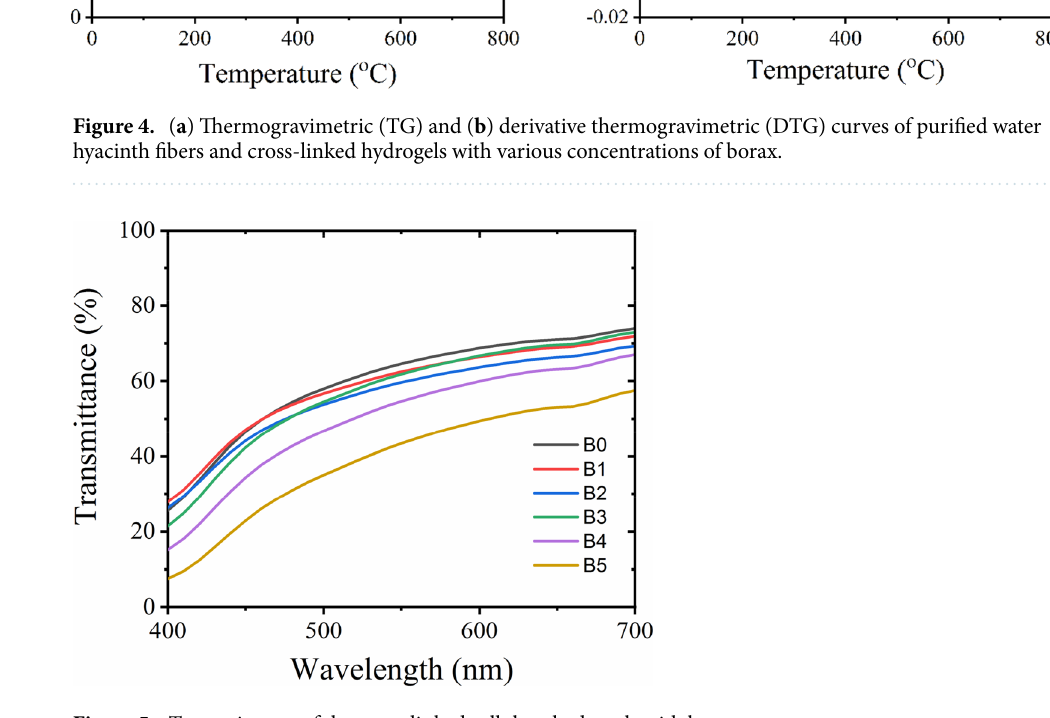
Figure 5. Transmittance of the cross-linked cellulose hydrogels with